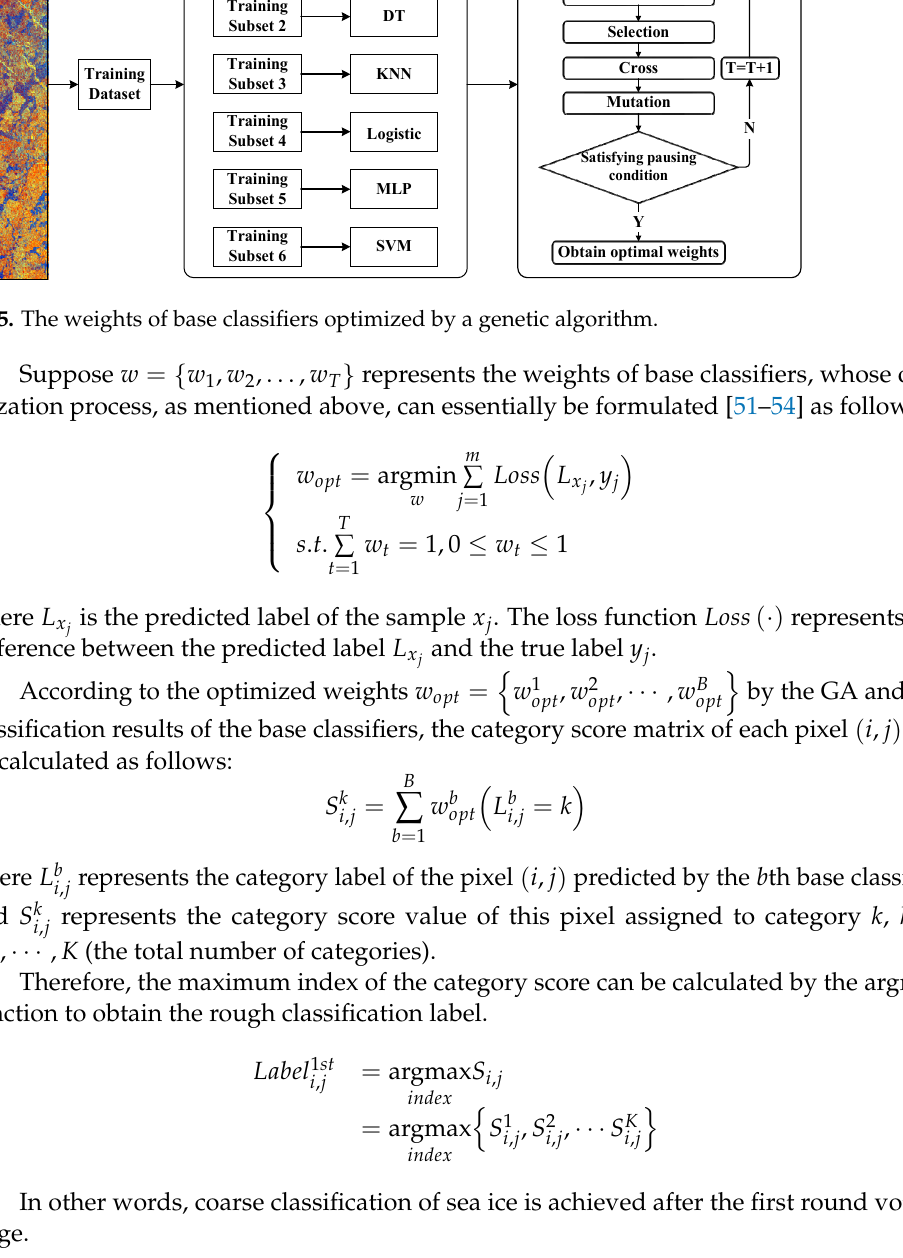
Figure 6. Second weight voting stage rectifying fuzzy pixels based on the local similarity of the neighboring explicit pixels.